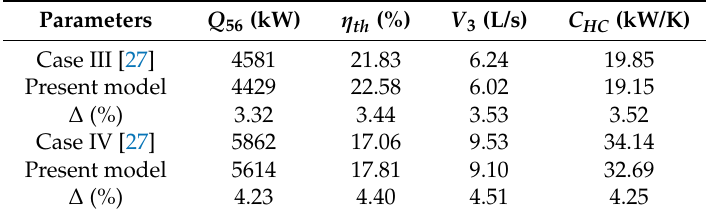
Table 4. Comparison of TLC results between the present computation and reference [27].